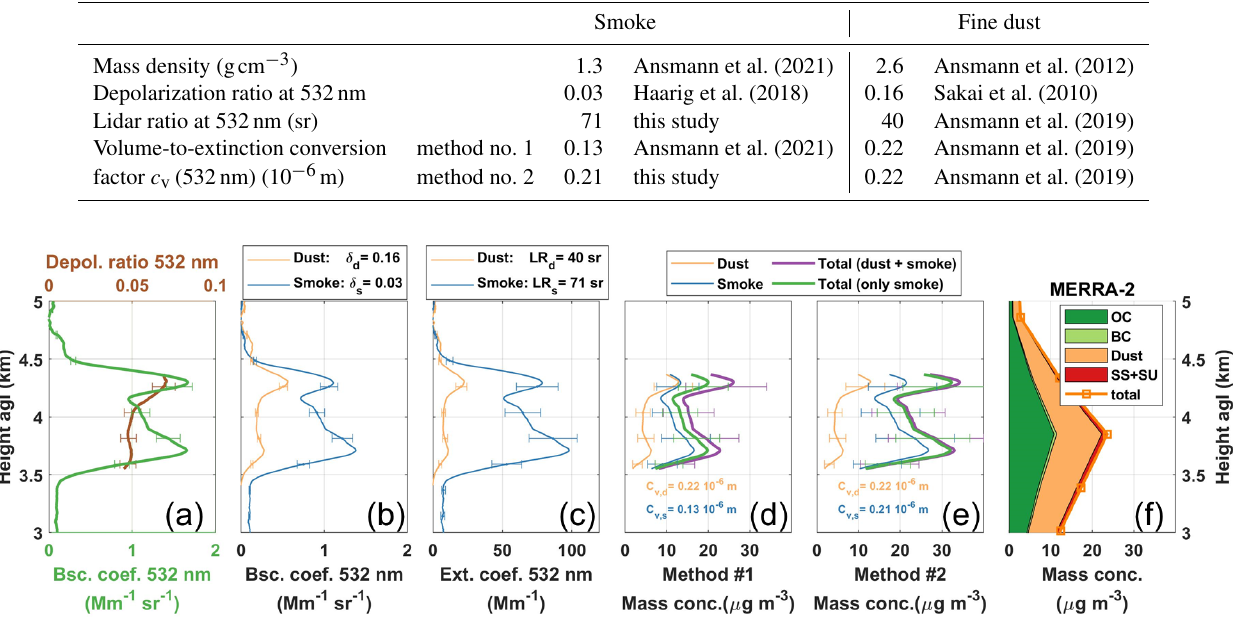
Figure 8. Lidar products obtained from Polly XT measurements on 5 June 2019, 08:00–10:00UTC (2h signal average). (a) Measured 532nm total particle backscatter coefficient (green) and particle linear depolarization ratio (brown). (b) Particle backscatter coefficients (BSCs) for fine dust (orange) and smoke (blue) particles, obtained with the POLIPHON method. (c) Respective fine dust and smoke extinction coefficients (EXTs) obtained by multiplying the BSCs (in b ) with the lidar ratios. (d, e) The fine dust (orange) and smoke (blue) particle mass concentrations derived from the EXT profiles (in c ), by using parameters in Table 4 for method no. 1 (d) and no. 2 (e) . The total mass concentrations of fine dust and smoke mixture (purple) or of only smoke particles (green) are shown. (f) Mass concentrations of organic carbon (OC, dark green), black carbon (BC, light green), dust (orange), sea salt, and sulfate (SS + SU, red) from the MERRA-2 model at 09:00UTC on 5 June. The total mass concentration profile is also given by orange squares. The horizontal lines illustrate the uncertainty